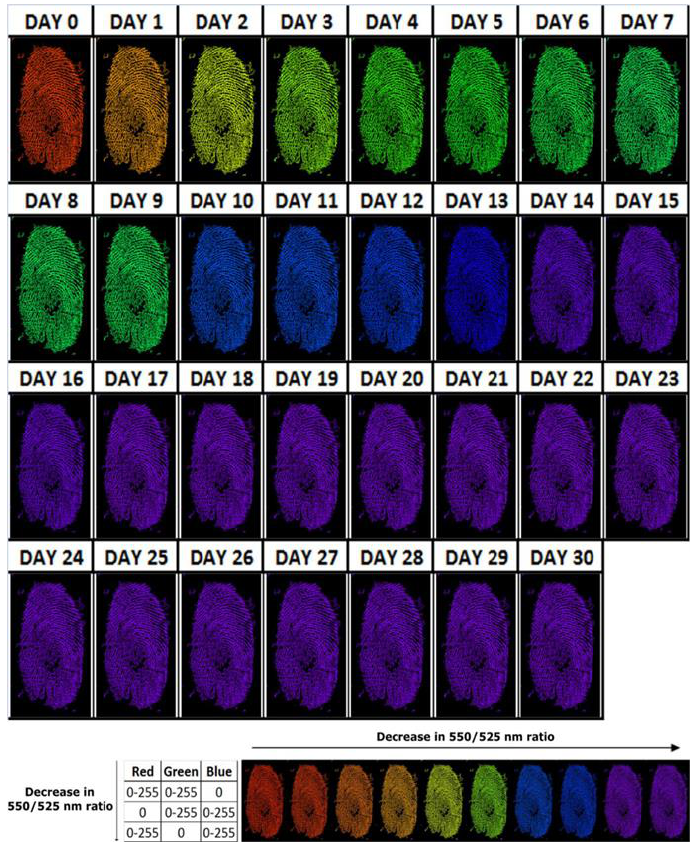
Figure 6. 30-day false colour aging scale.